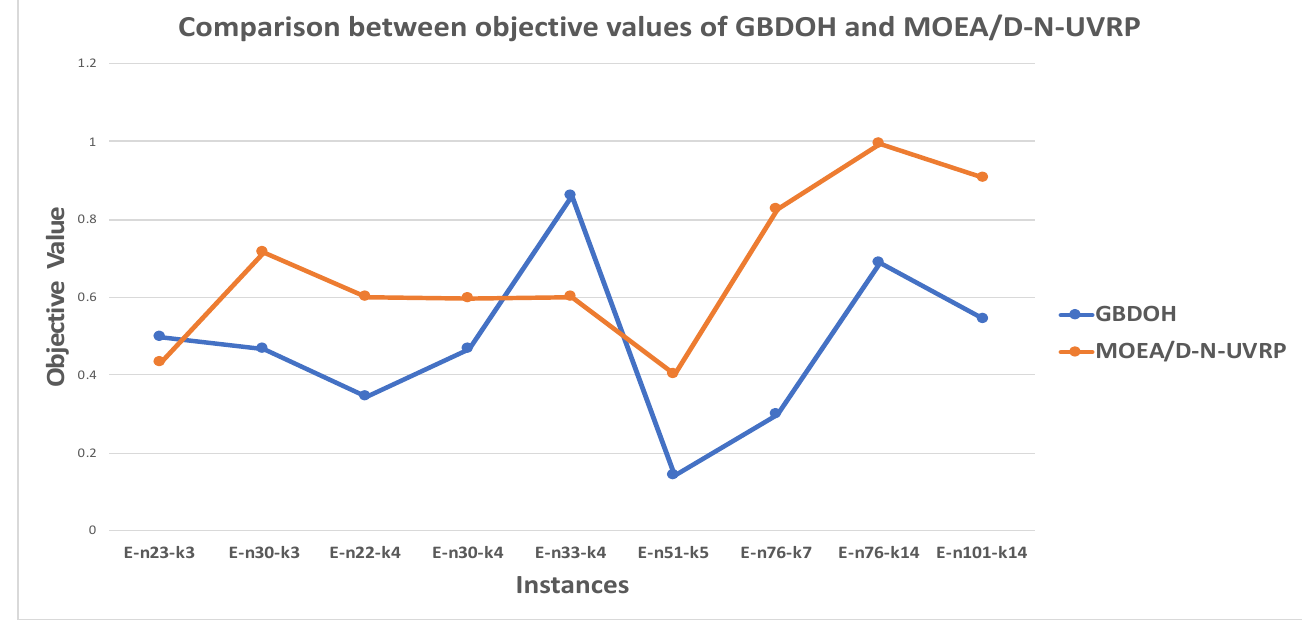
Figure 5. Comparison between the objective values of the GBDOH and MOEA/D-N-UVRP on nine instances from the (Christofides and Eilon, Set E) benchmark.